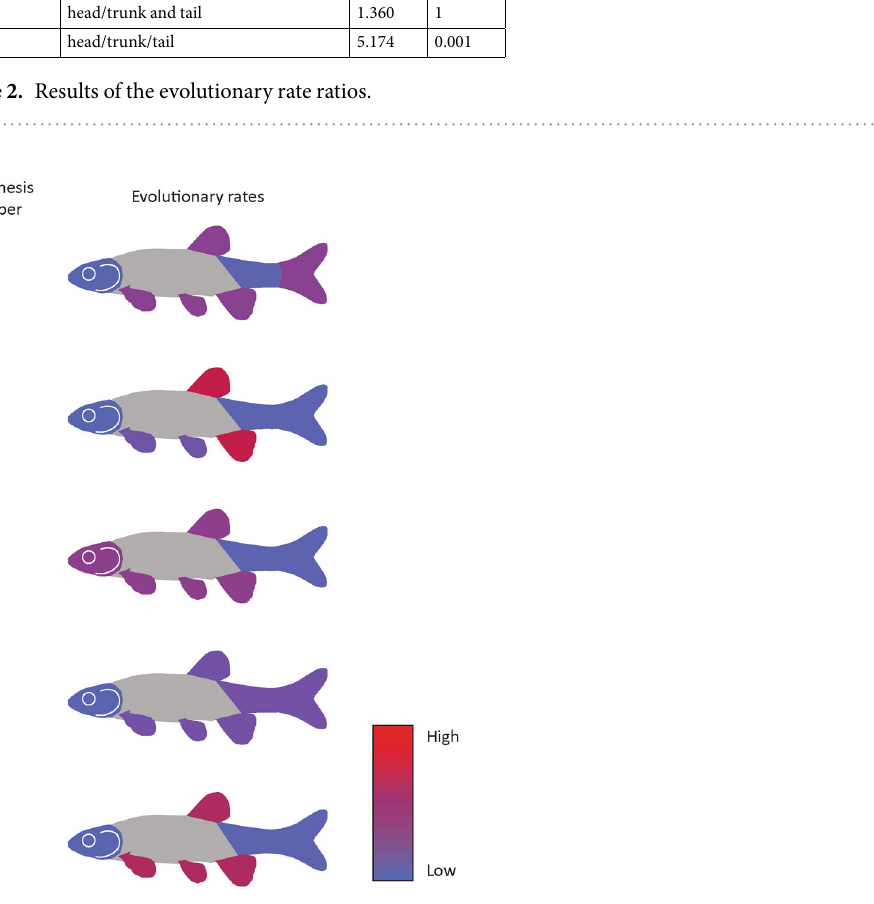
Figure 2. Evolutionary rate estimates for the partitions of the five best-fitting modularity hypotheses. Shades of blue represent lower evolutionary rates, whereas shades of red represent higher evolutionary